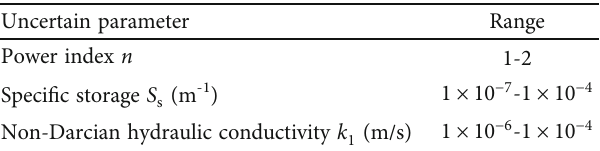
Figure 13: Hydraulic head in the aquifer ( r = 3 m) with m = 0 : 95 m, = 30 m, n = 1 : 2 , and S = 1 × 10 − 4 m -1 for the values of power s s w index k 1 = 2 × 10 − 7 , 2 × 10 − 6 , 2 × 10 − 5 , 2 × 10 − 4 , and 2 × 10 − 3 m/s, Table 2: Ranges of parameters used in the global sensitivity analysis.